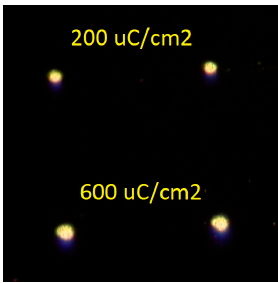
Figure 3. Optical microscope image of Mo 8 -only film patterning quality under electron-beam lithography (EBL).